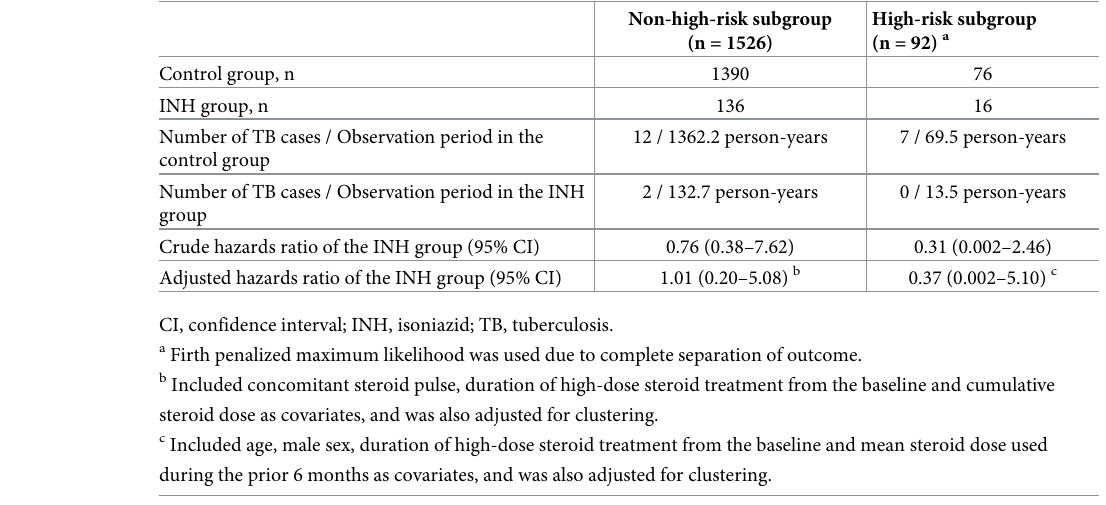
Table 3. The effect of prophylactic INH on the 1-year incidence of TB according to the presence of risk